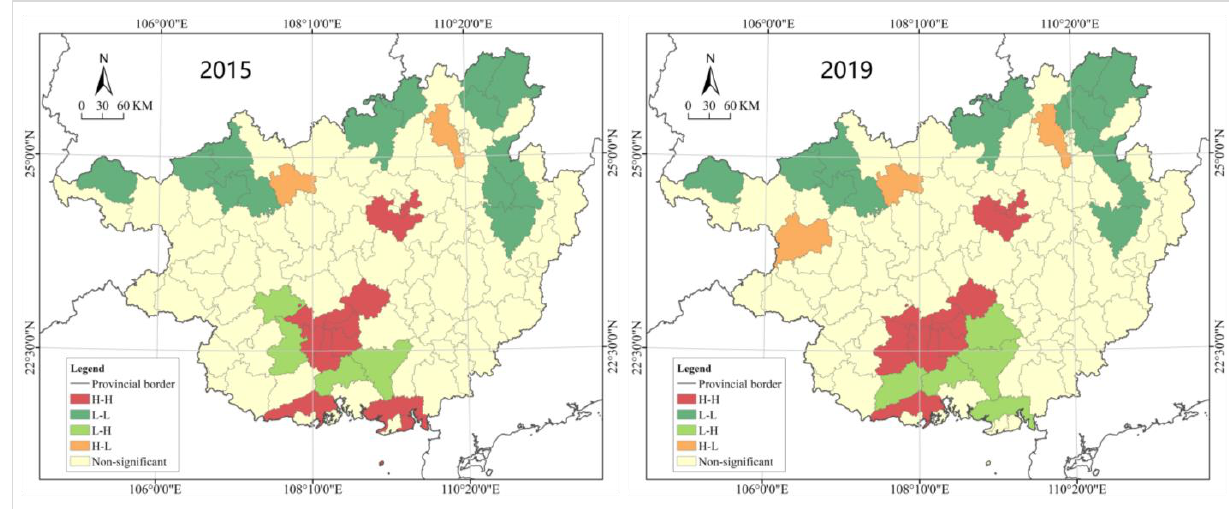
Figure 7. Spatial correlation analysis of night light extended vitality index in Guangxi.